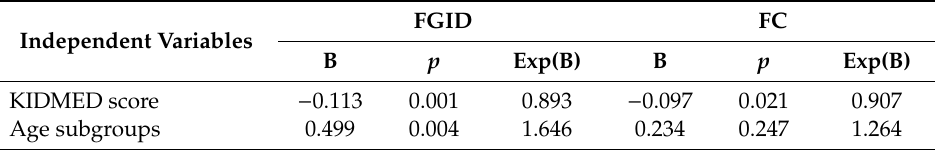
Table 4. Results of the two multiple regression models (generalized linear models, binary logistic method) with dependent variables the occurrence of FGIDs and FC,